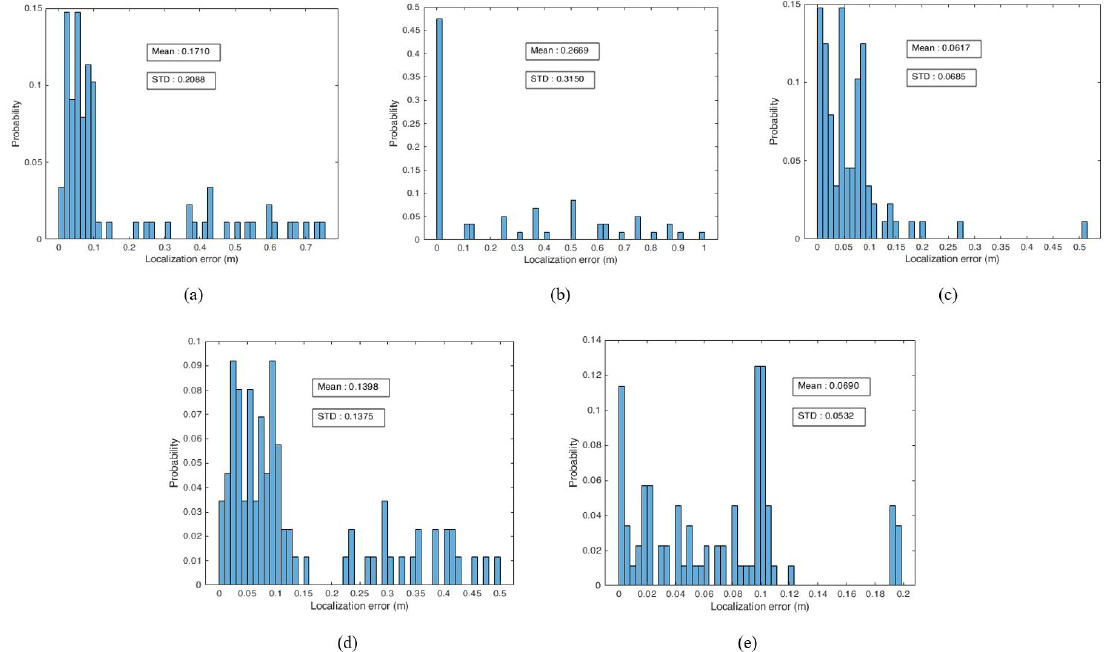
Figure 7. Probability distribution of localization errors. ( a ) IMU-based localization. ( b ) ORB-SLAM localization. ( c ) UcoSLAM localization. ( d ) ORB-SLAM + IMU. ( e ) UcoSLAM +